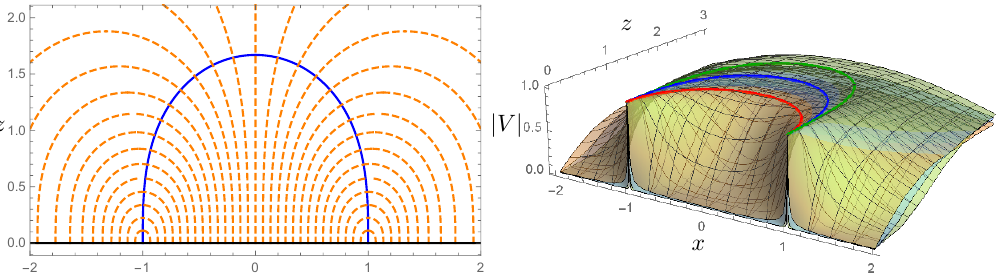
Figure 3 . Vector lines for a strip in d = 2 spatial dimensions (to be compared with the d = 1 case, shown in (cid:12)gure 2) and magnitude j V j for d = 1 (orange), d = 2 (blue) and d = 3 (green), respectively. The vector (cid:12)elds V exhibit translational invariance along the transverse directions, which have been omitted for simplicity. The solid line(s) corresponds to the minimal surface(s), m ( A ). These curves also signal the location where the magnitude of the vector (cid:12)elds attains its maximal value, j V j = 1. In general, we observe that the integral curves get elongated and reach deeper into the bulk as the number of dimensions is increased. This property is inherited from their corresponding minimal